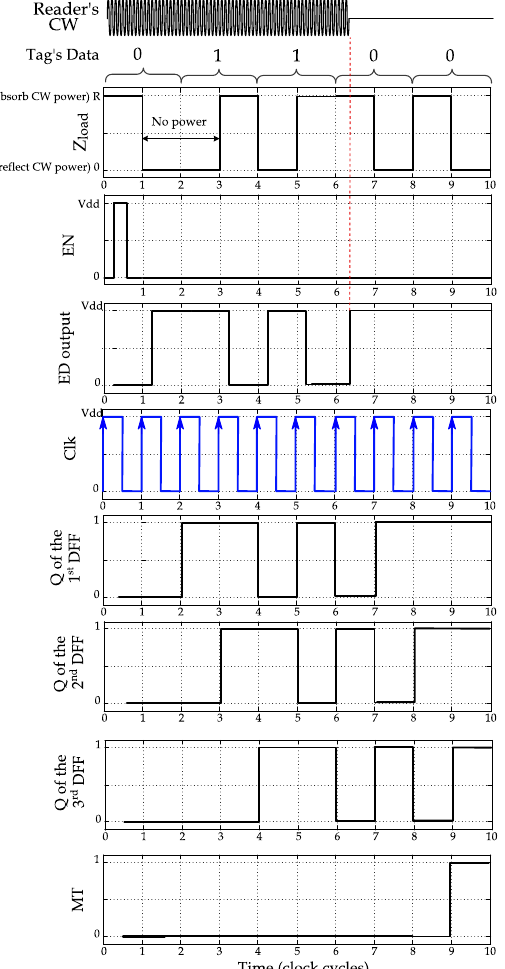
Figure 6. Timing diagram example of the DBMT outputs for a tag sending PIE encoded stream of bits starting by 01100··· and CW cutoff by the reader at the 4th bit.